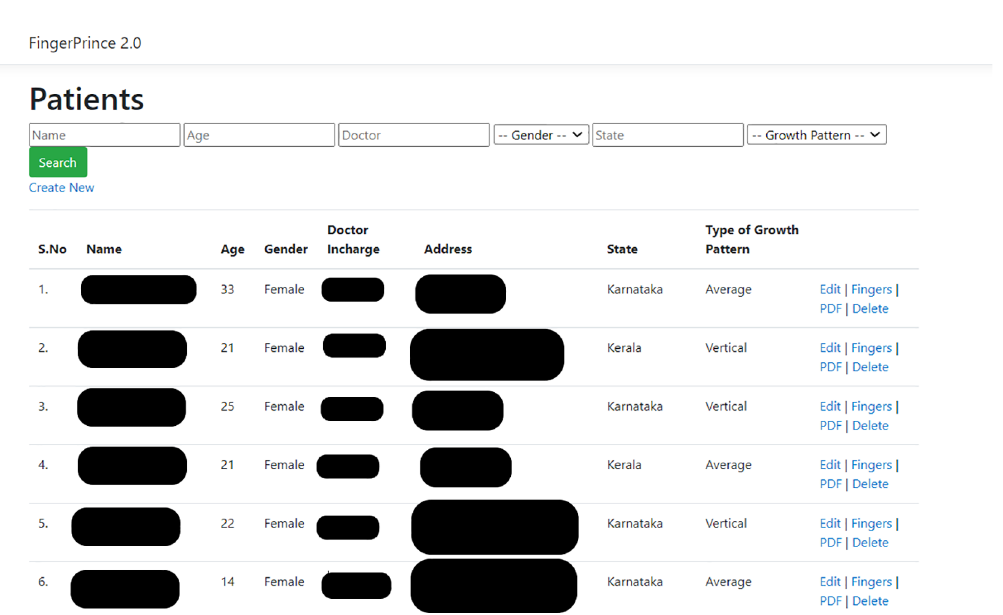
Figure 1. Index of subjects data as seen in the ‘ Fingerprince ’